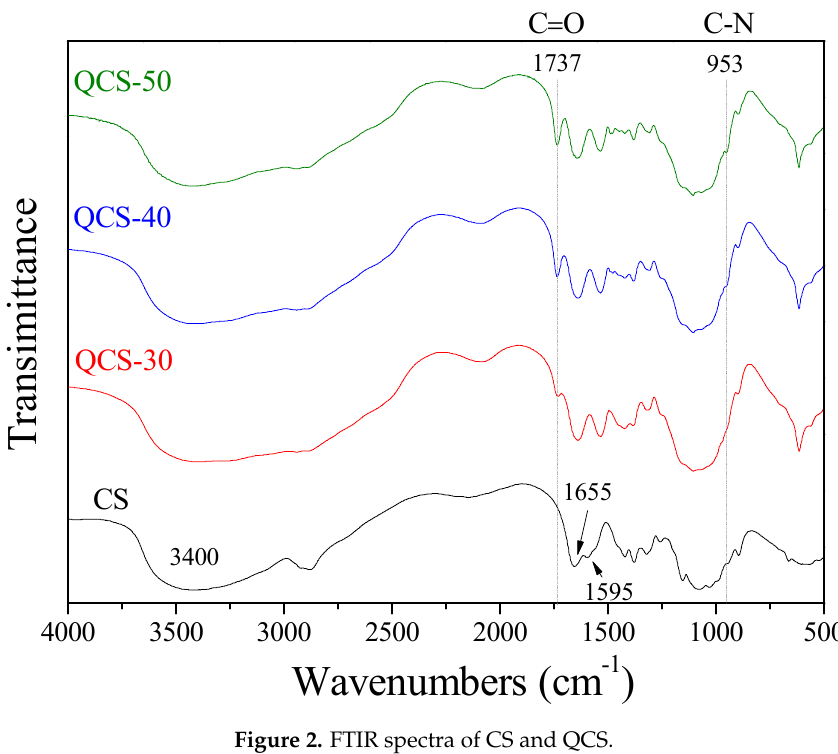
Figure 2. FTIR spectra of CS and QCS.